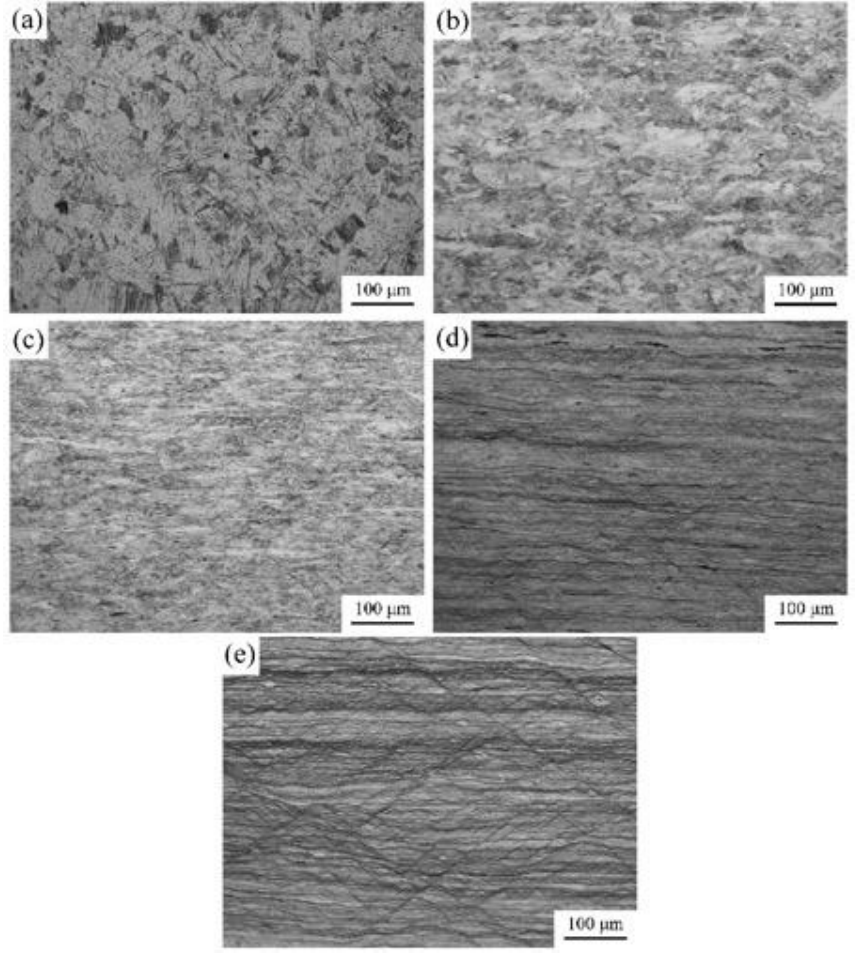
Figure 3. Microstructures of TWIP steel at various CR deformation levels: ( a ) 5%, ( b ) 25%, ( c ) 50%, ( d ) 75%, and ( e ) 88%.